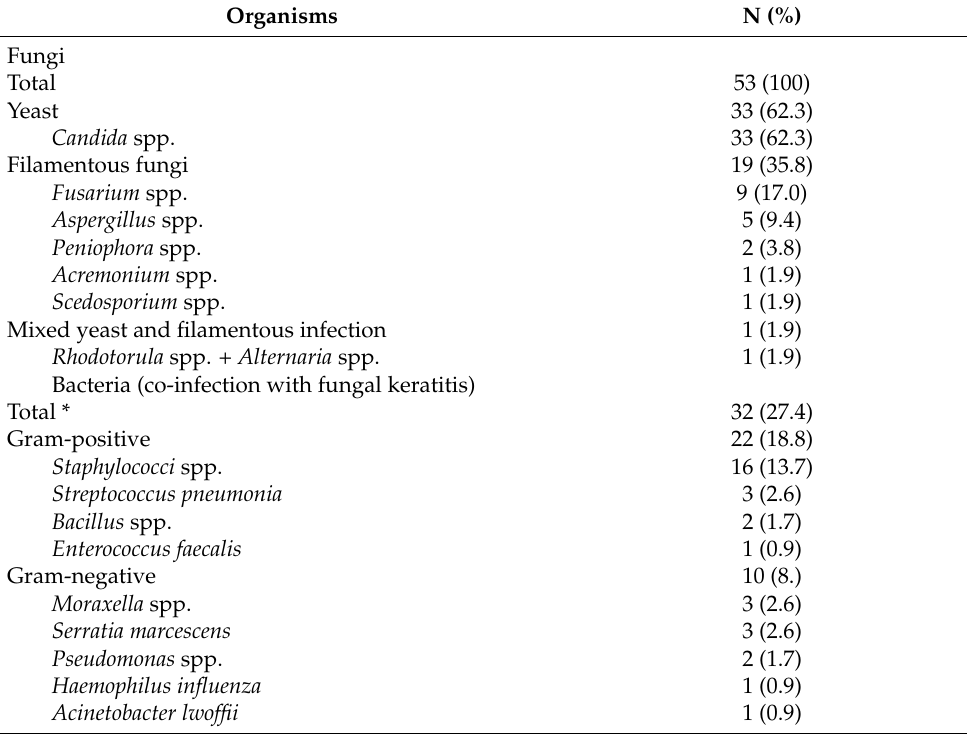
Table 2. Causative organisms of fungal keratitis and/or co-infection with bacteria that presented to the Queen’s Medical Centre, Nottingham, UK and Queen Victoria Hospital, East Grinstead, UK,